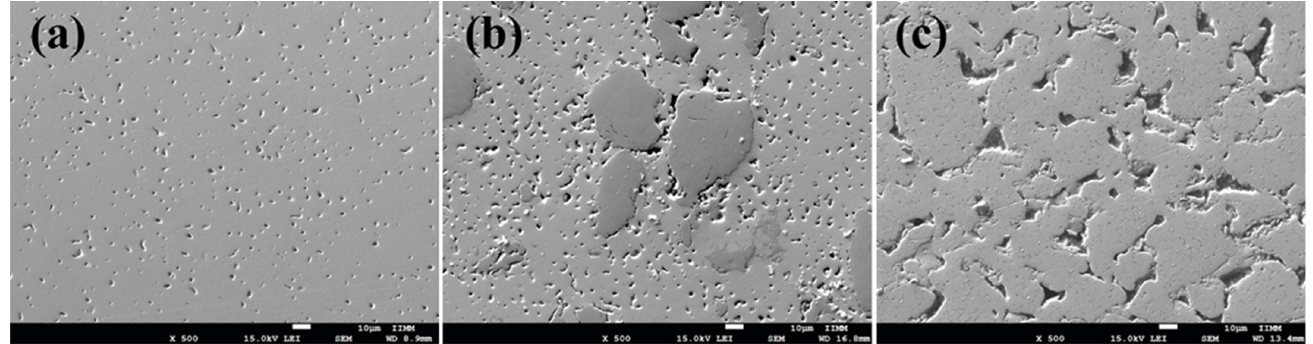
Figure 2. Scanning electron micrographs of ( a ) Ni-based, ( b ) NiCr-m, and ( c ) NiCr-p electrodes’ surfaces.